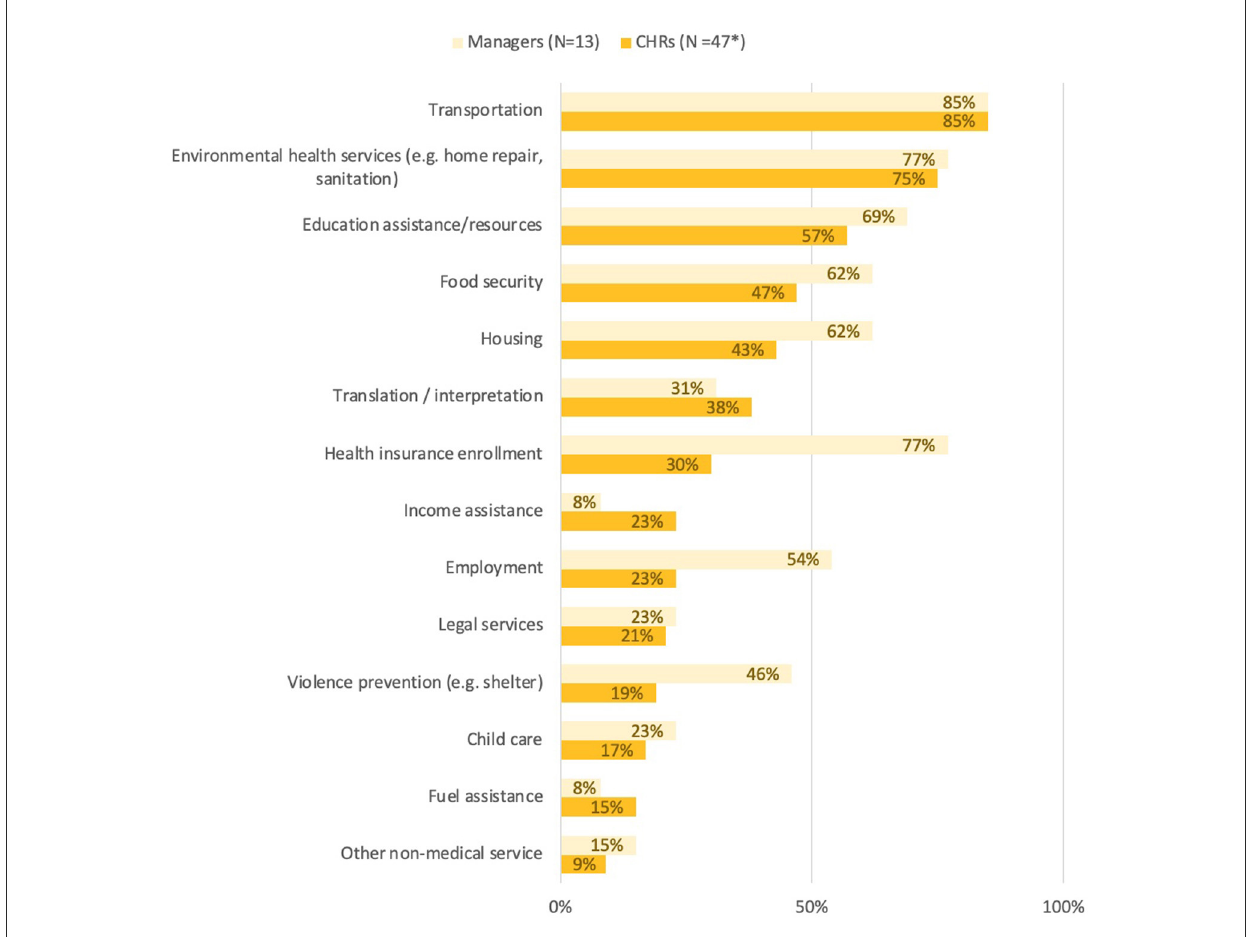
FIGURE2 CHR referral